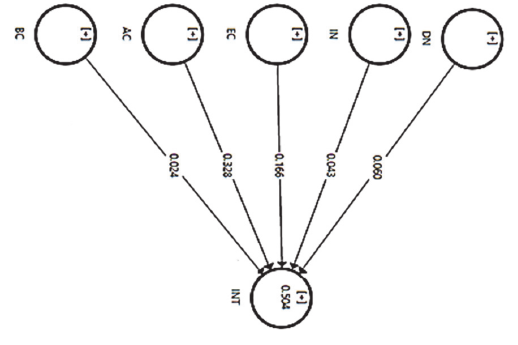
Fig. 2. Structural Model Path Coefficient